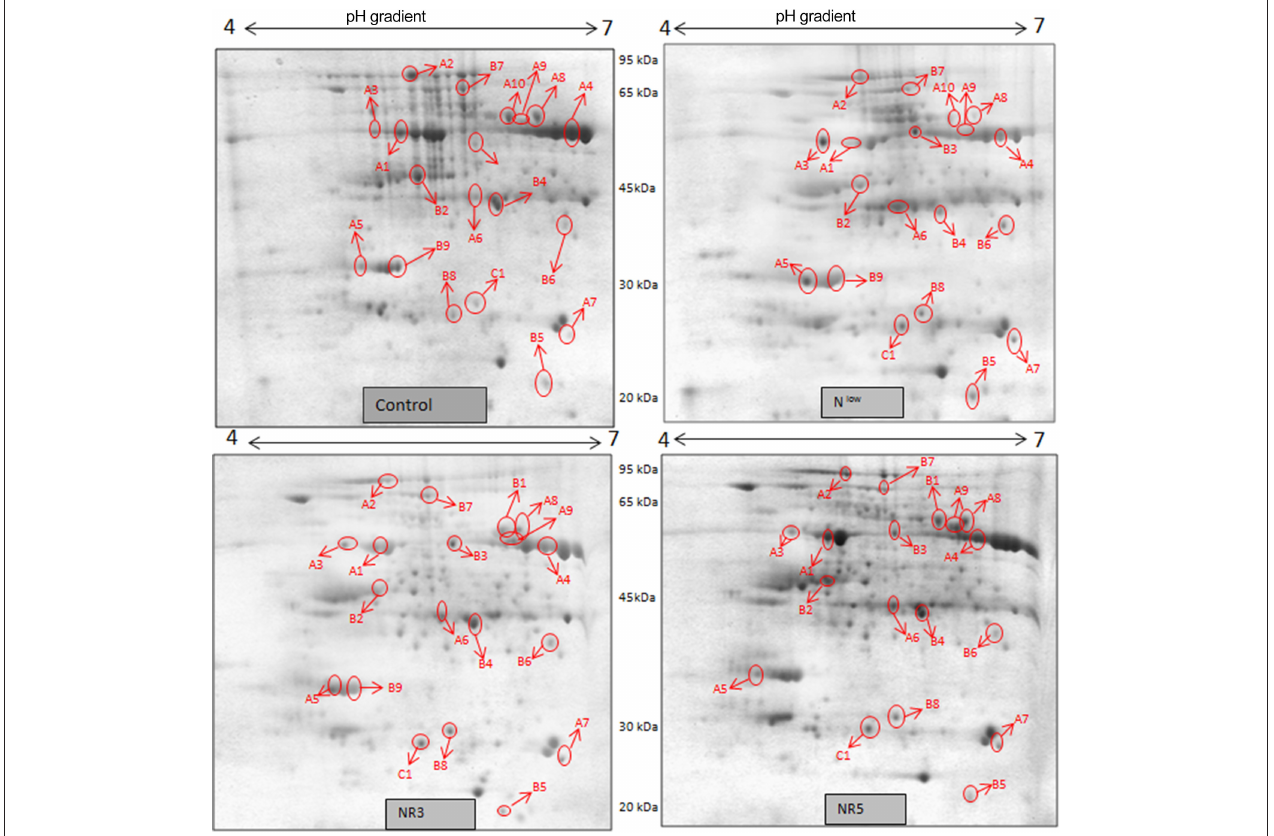
FIGURE 3 | 2DE maps representing differential protein intensities between different N treatments of PEHM-2.